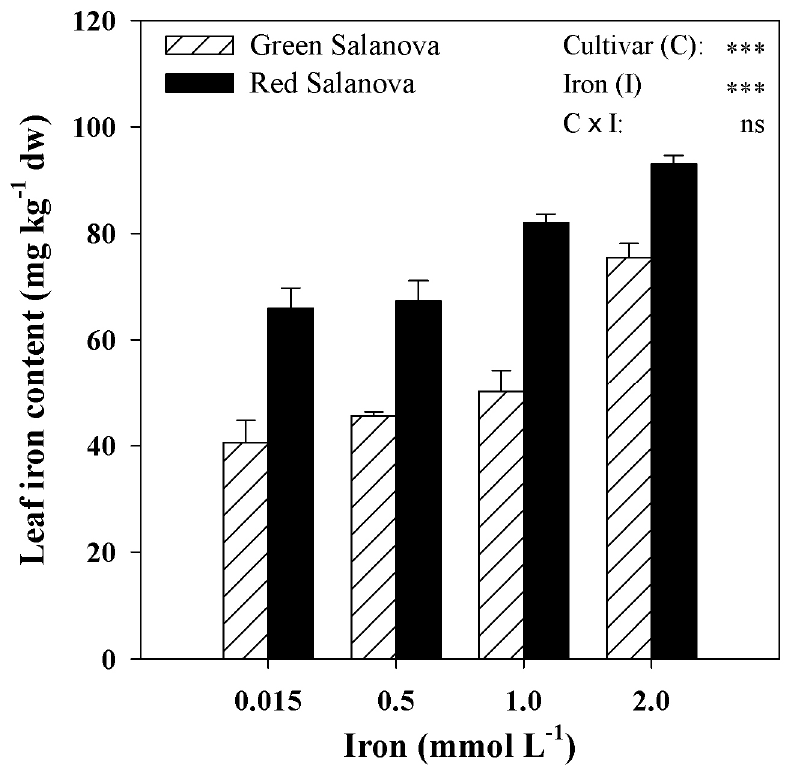
Figure 1. Effects of cultivar and iron concentration in the nutrient solution on Fe accumulation in lettuce leaves. Different letters indicate significant differences according to Tukey’s HSD test ( P = 0.05). The values are means of three replicates. Vertical bars indicate ± standard deviation of means.